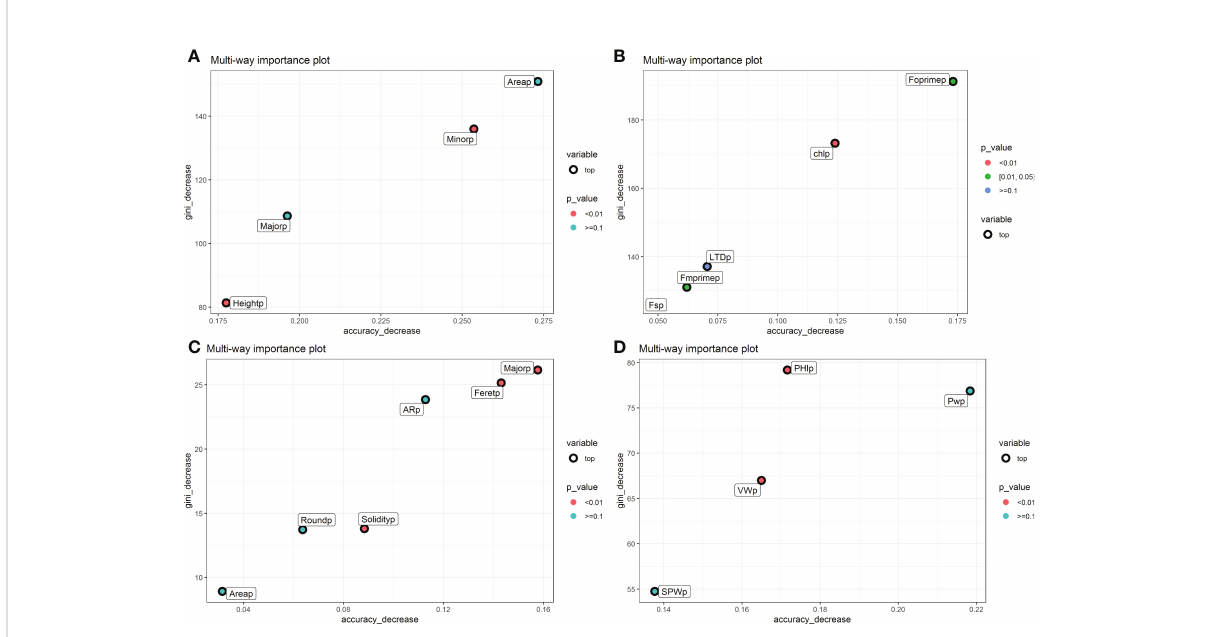
FIGURE 4 Gini index and accuracy decrease for feature selection in random forest for each characterization component in the hybrid. (A) Seed morphometric component, (B) Physiological component, (C) Pod morphometric component and (D) Yield component. The weighted phenomic descriptors are observed. The fi gure shows the phenomic descriptors of major importance in the classi fi cation of the parental accessions and the interspeci fi c